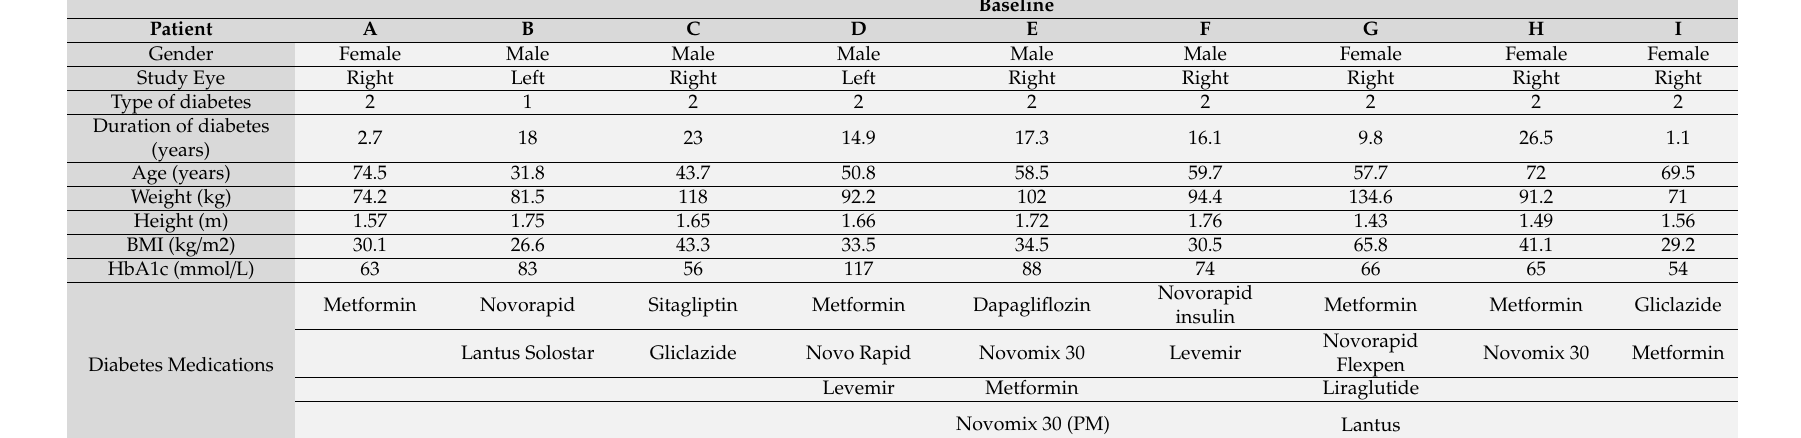
Table 2. Baseline characteristics of